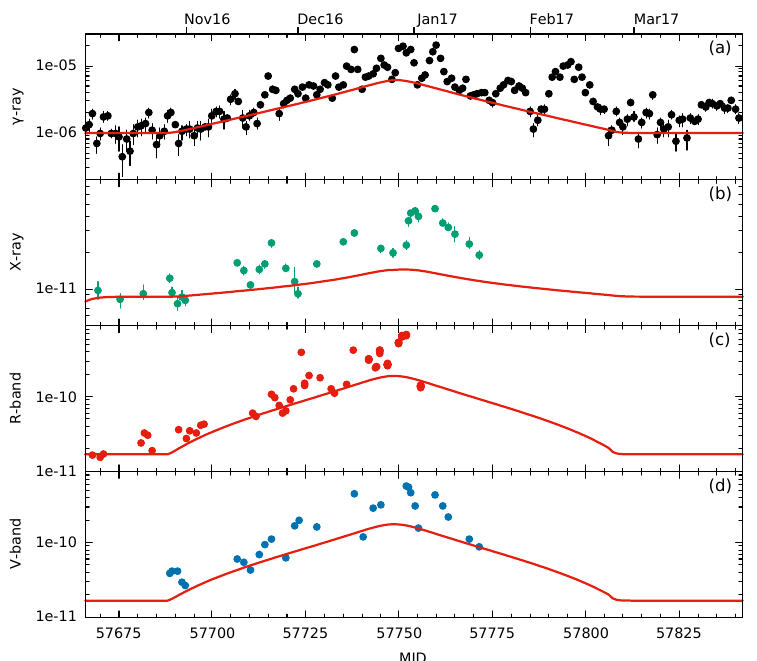
Figure 4. Model light curves (red curves) using a hadronic model within the dusty torus (DT) for the γ -ray, X-ray, R- and V-band